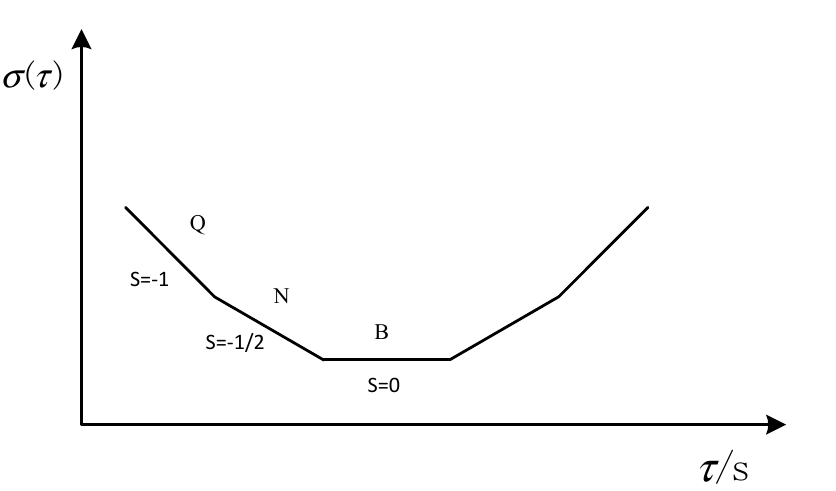
Figure 3. Diagram of the Allan mean square deviation for the MEMS gyroscope random error.